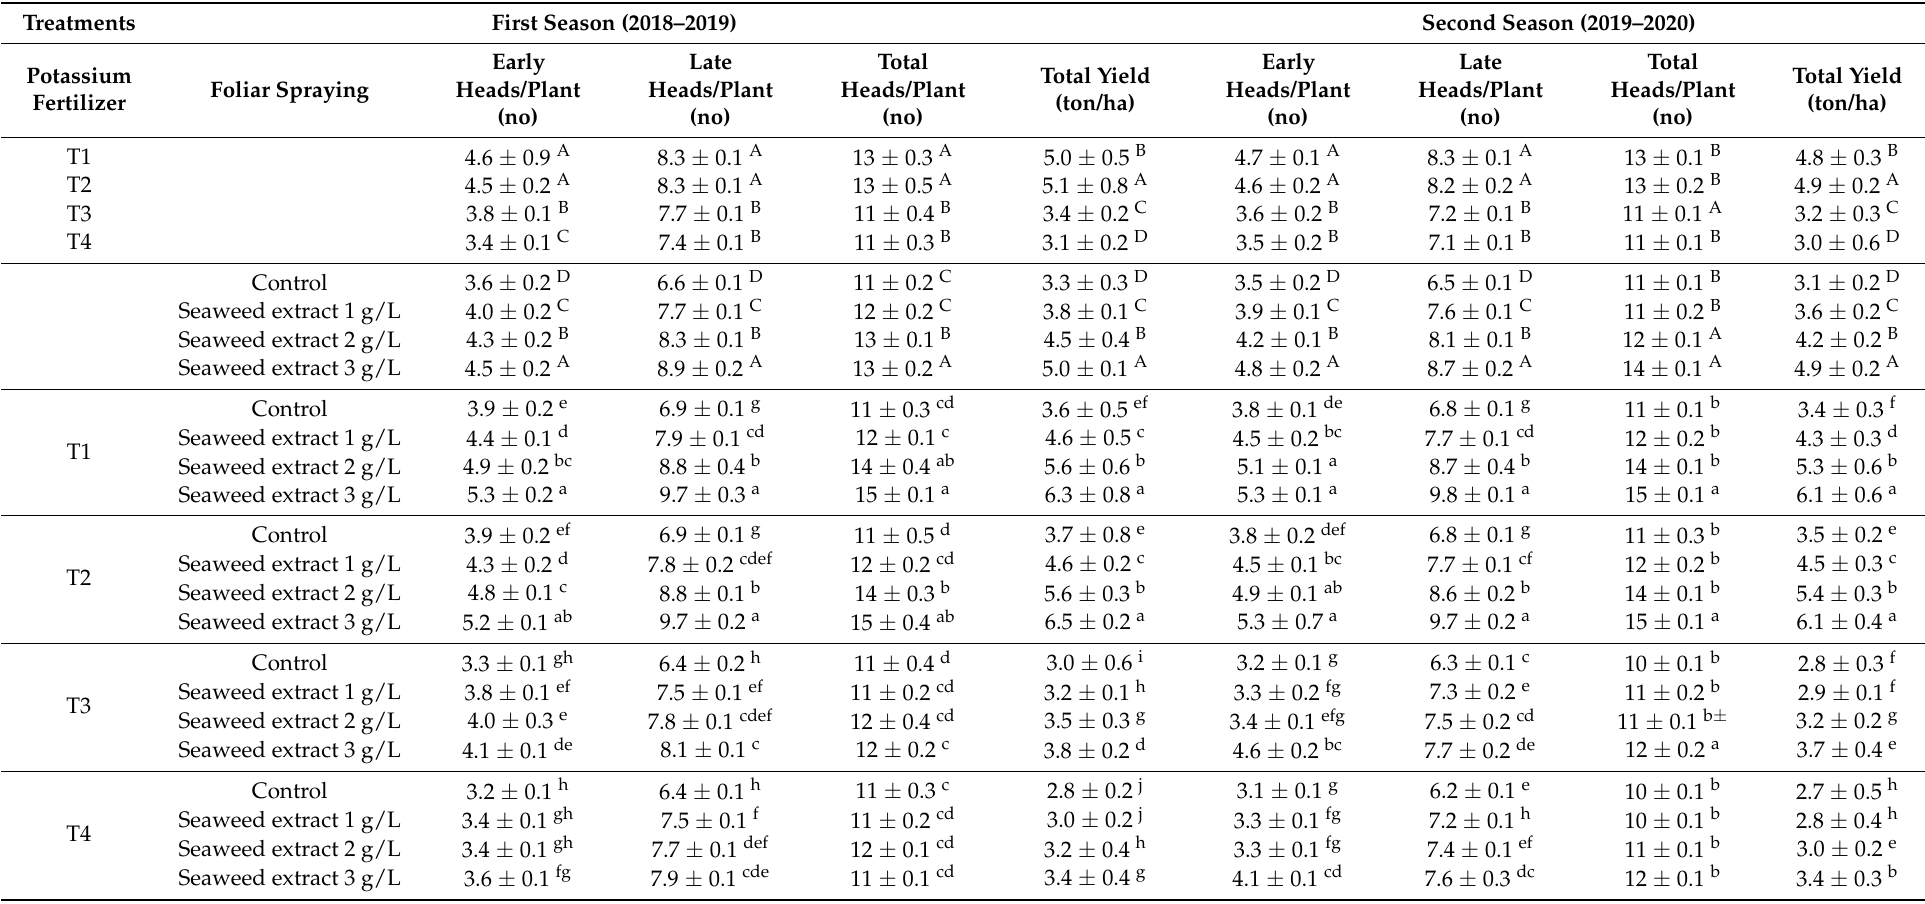
Table 6. The effect of potassium fertilizer, biofertilizer, and foliar spraying of seaweed extract on yield parameters of globe artichoke.